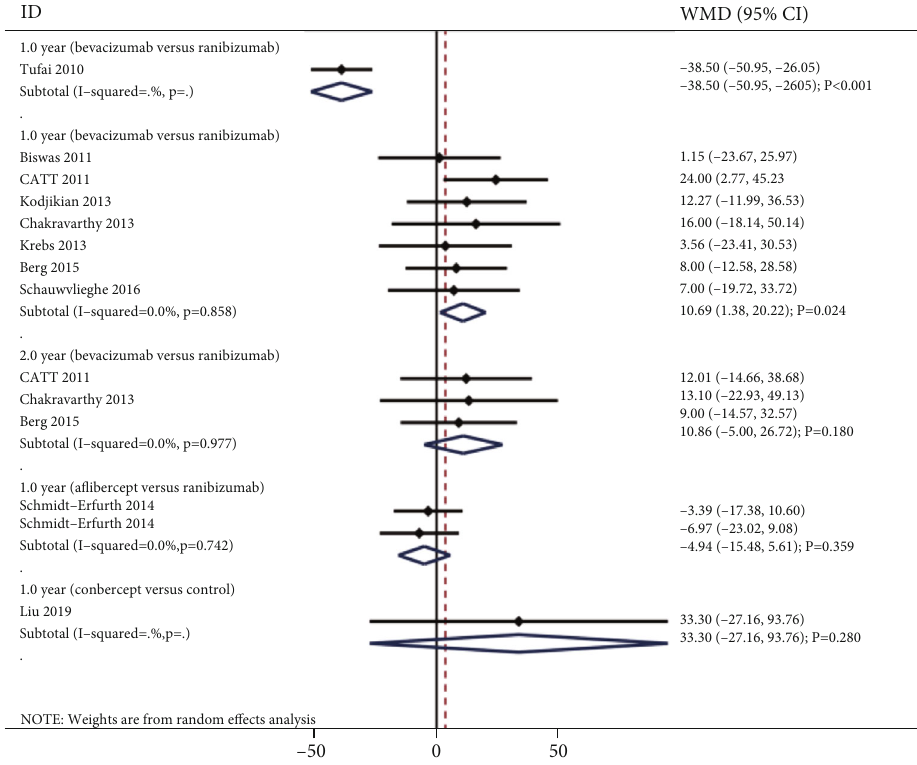
Figure 3: E ff ect of anti-VEGF inhibitors on the change of central macular Figure 2. We noted that pegaptanib (WMD: 6.70; 95% CI: 4.40 to 9.00; P < 0 : 001 ) and ranibizumab (WMD: 17.80; 95% CI: 15.95 to 19.65; P < 0 : 001 ; no evidence of heteroge- neity) were associated with greater changes in BCVA after 1 year when compared with non-anti-VEGF inhibitors.